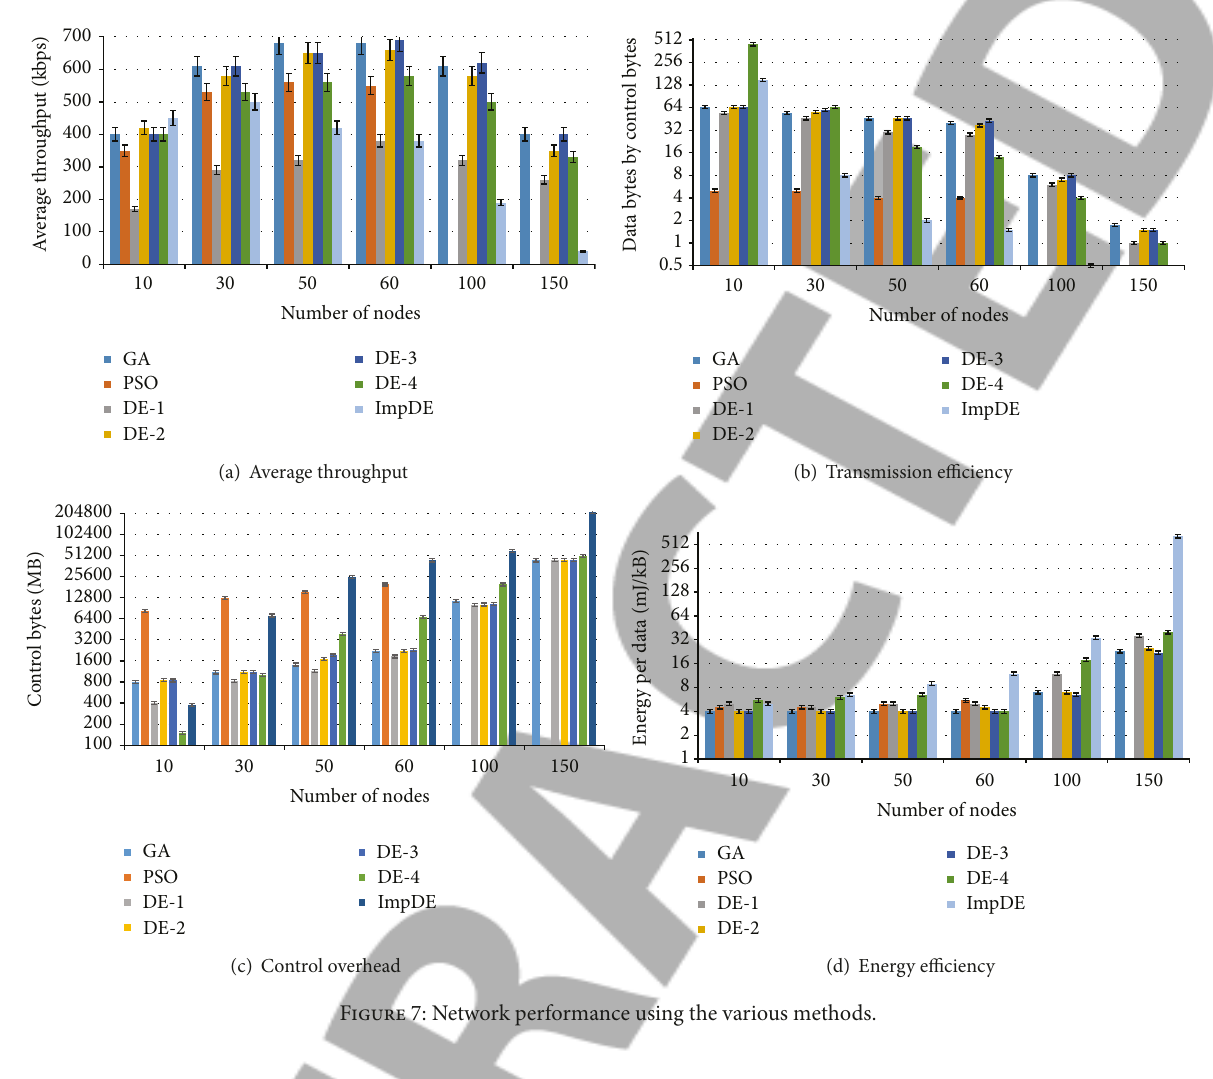
Figure 7: Network performance using the various